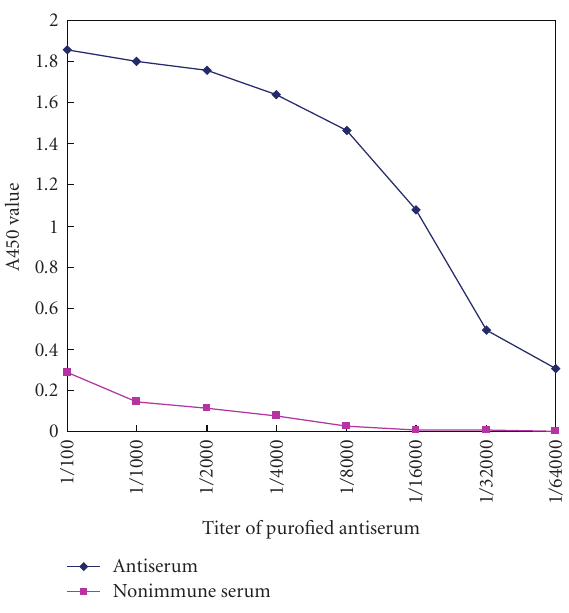
Figure 4: The titer of antiserum by ELISA. The antibody titer is defined as the highest dilution of serum at which the A450 ratio (A450 of postimmunization sera/A450 of preimmunization sera) is greater than